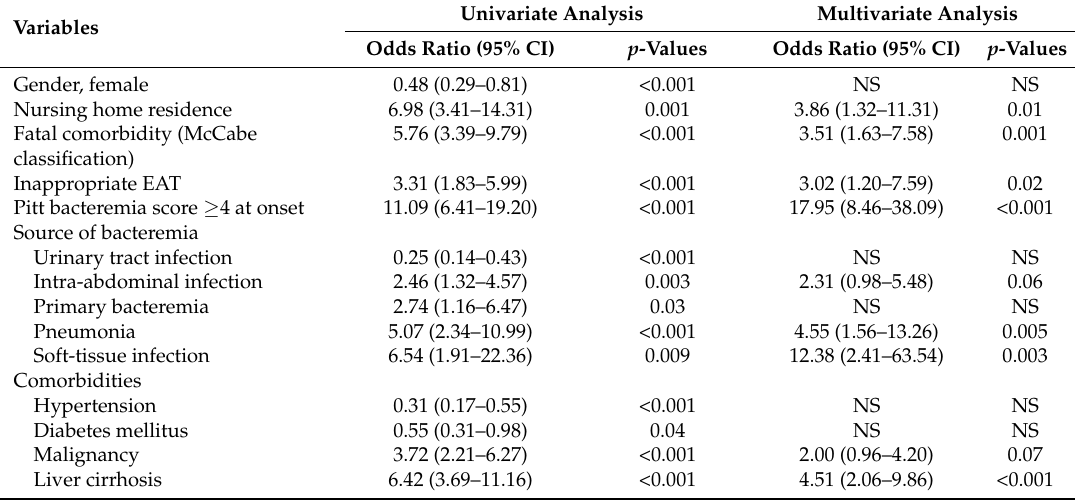
Table 4. Clinical predictors of 28-day mortality in 843 adults with community-onset monomicrobial Escherichia coli bacteremia.